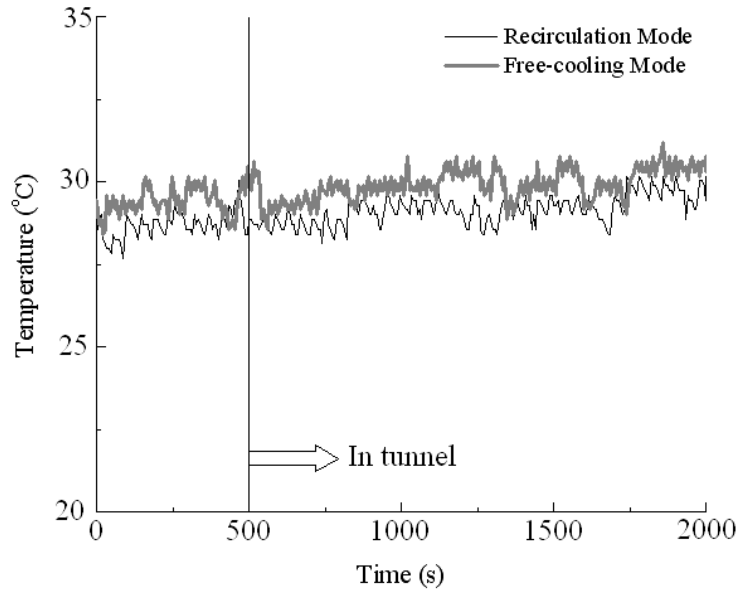
Figure 4. Time histories of thermocouple measured temperature in the two ventilation modes.